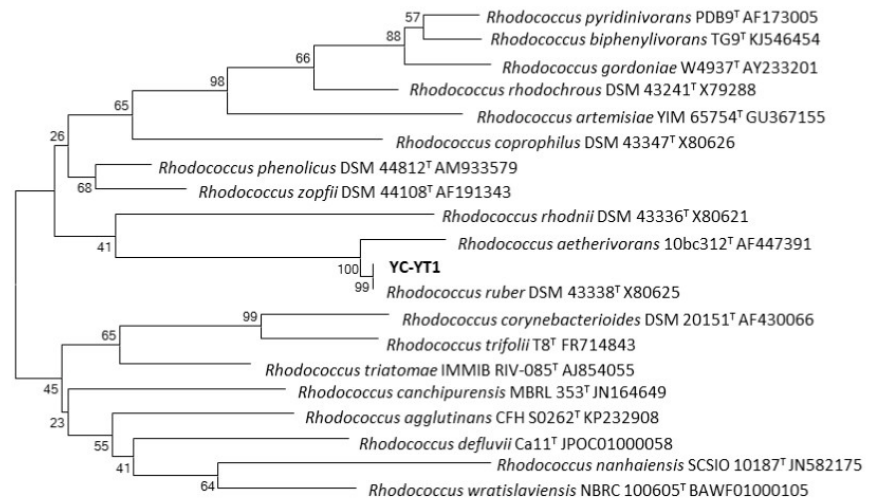
Figure 2. Phylogenetic analysis of strain YC-YT1 based on 16S rRNA gene sequence analysis. The scale bar equals 0.02 changes per nucleotide position.